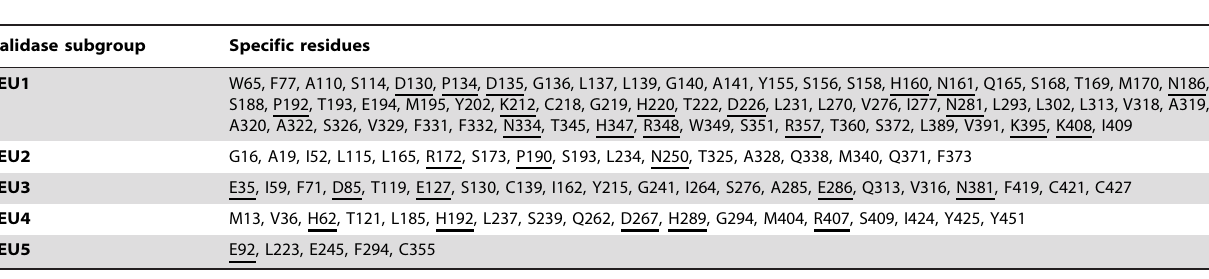
(Figure 4C). Finally, the comparison of known structures from viruses (such as Newcastle virus, Influenza B and Influenza N9 viruses), bacteria (such as C. perfrigens, S. pneumoniae, V. cholerae, S. tiphimurium ) and trypanosomes (such as Trypanosoma cruzi ) with NEU2 of human Table 3. Amino acid differences revealed by subfamily LOGO analysis comparing the 5 sialidase subgroups.